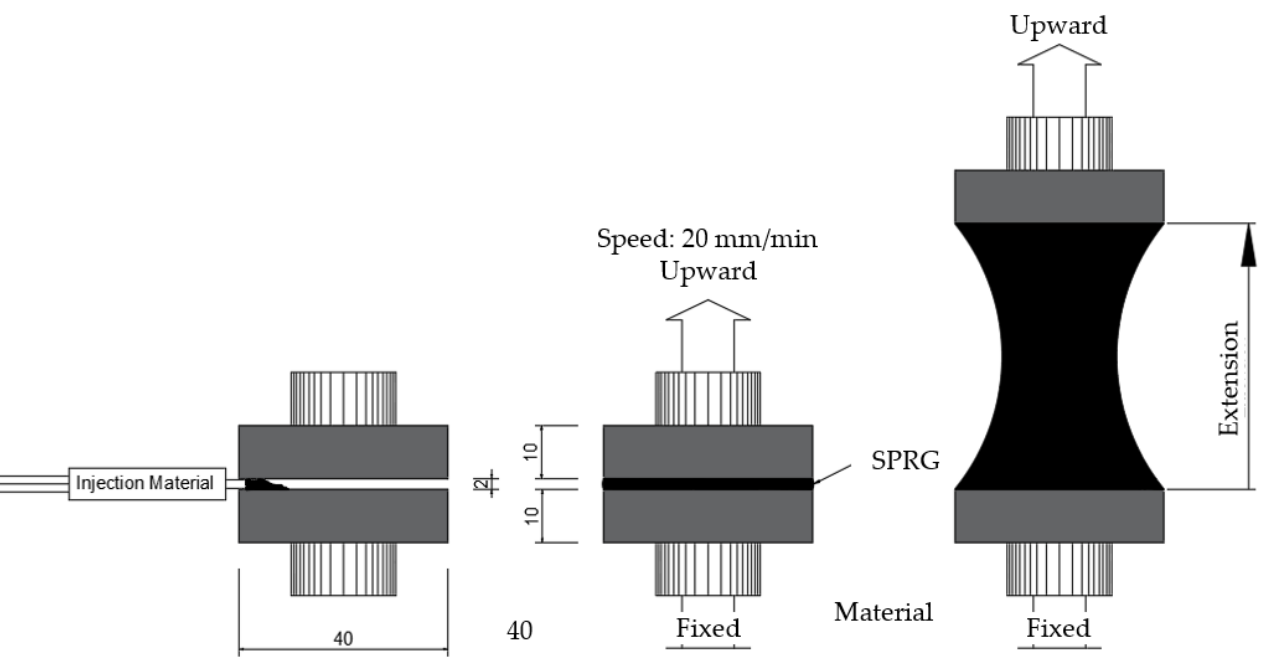
Figure 4. Cohesion test procedure based on SPRG thickness.